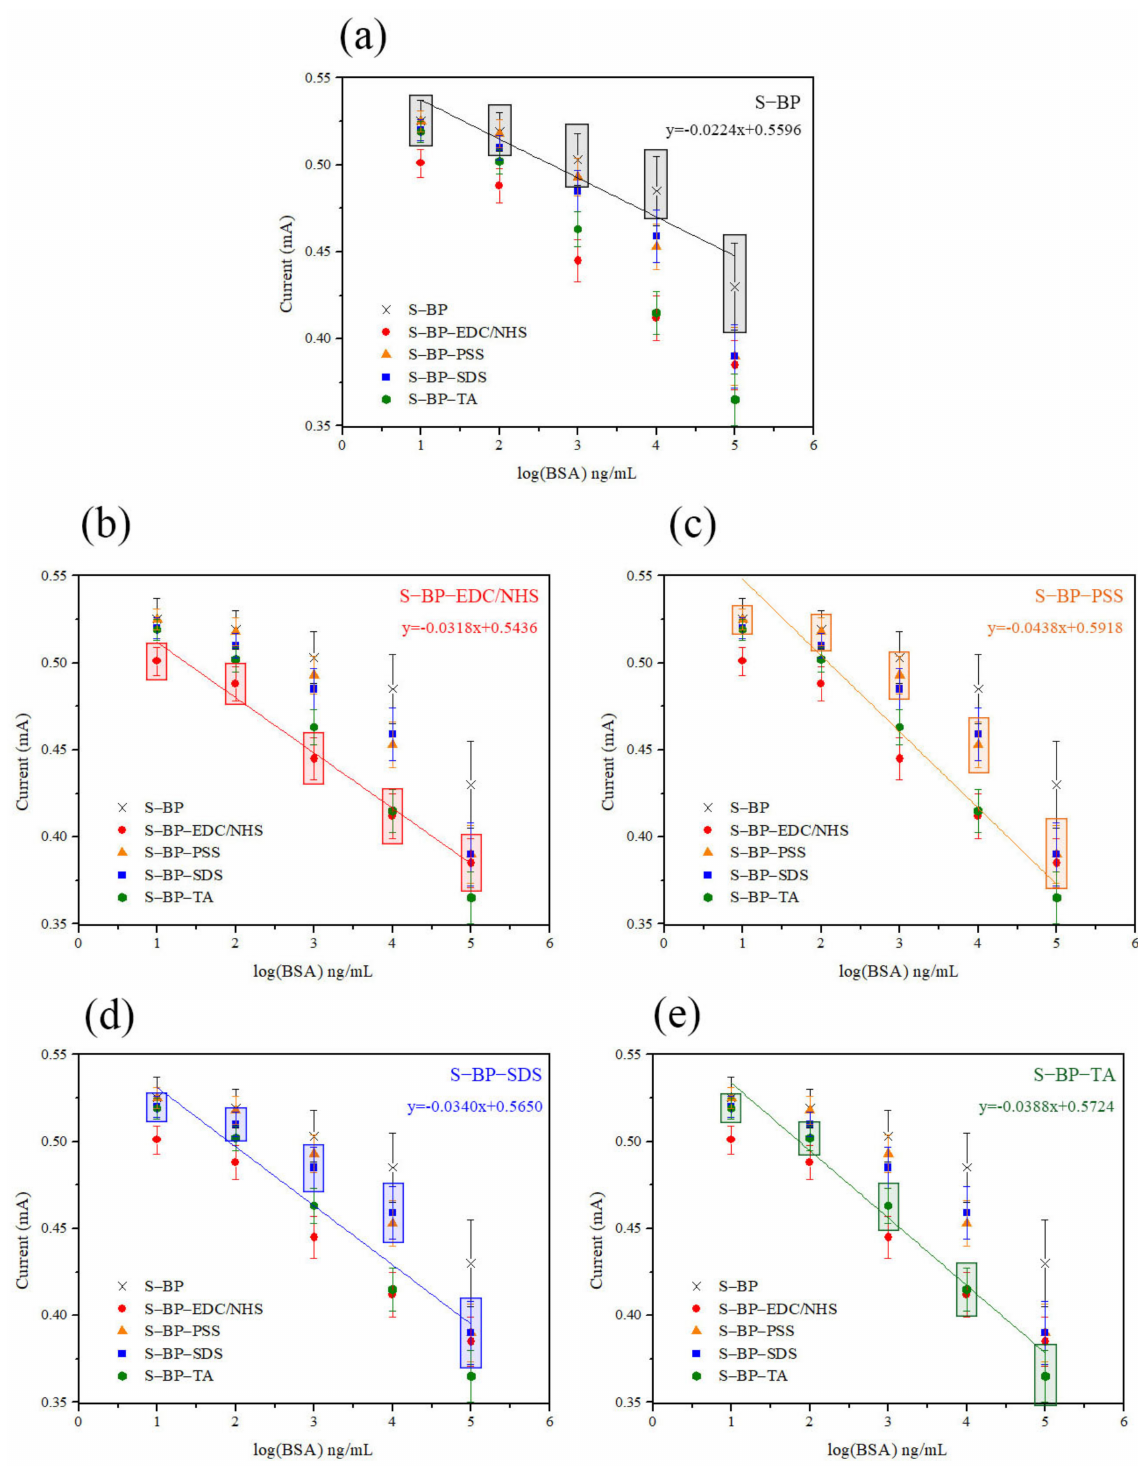
Figure 4. Linear regression analysis diagram of various specimens. ( a ) S–BP; ( b ) S–BP–EDC/NHS; ( c ) S–BP–PSS; ( d ) S–BP–SDS; ( e )